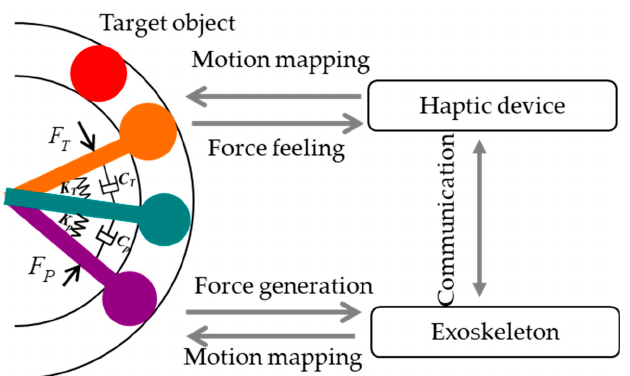
Figure 2. Proposed visually shared training model.